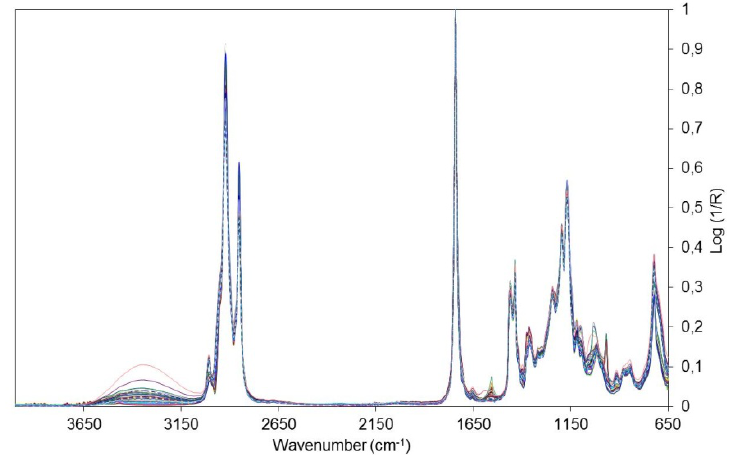
Figure 1. Spectra of samples of biodiesel obtained in the range 4,000 to 650 cm − 1